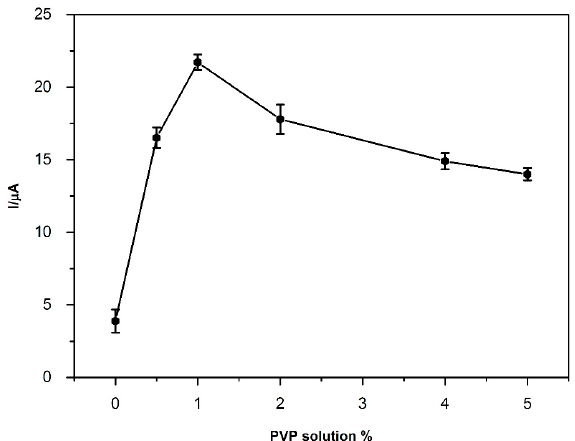
Figure 5. Effect of PVP concentration to peak current of 5 μ M BPA. Conditions: pH 7.0; Frequency: 50 Hz; Step amplitude: 40 mV; pulse amplitude: 5 mV; E deposition (E dep ): − 0.2 V; t deposition (t dep ): 60 s.